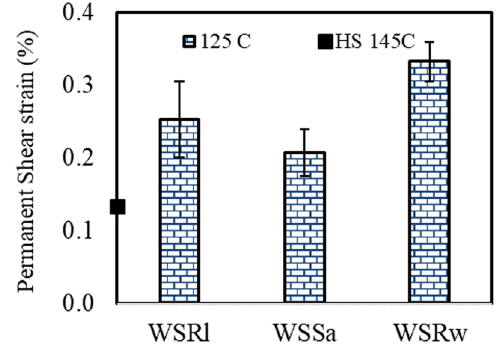
Figure 21: Final permanent shear strain at the termination of